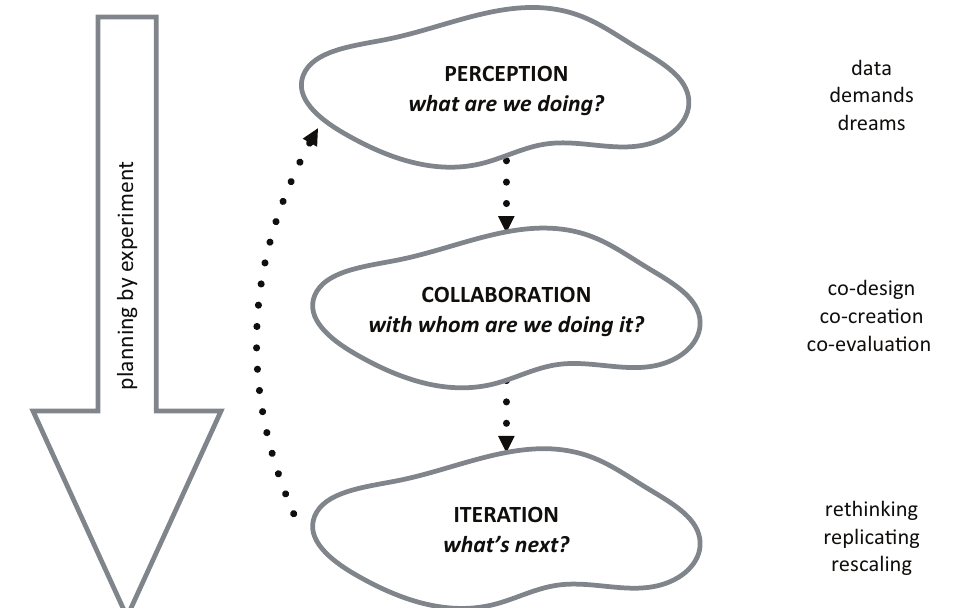
Figure 3. Processes underpinning the approach to planning by experiment at